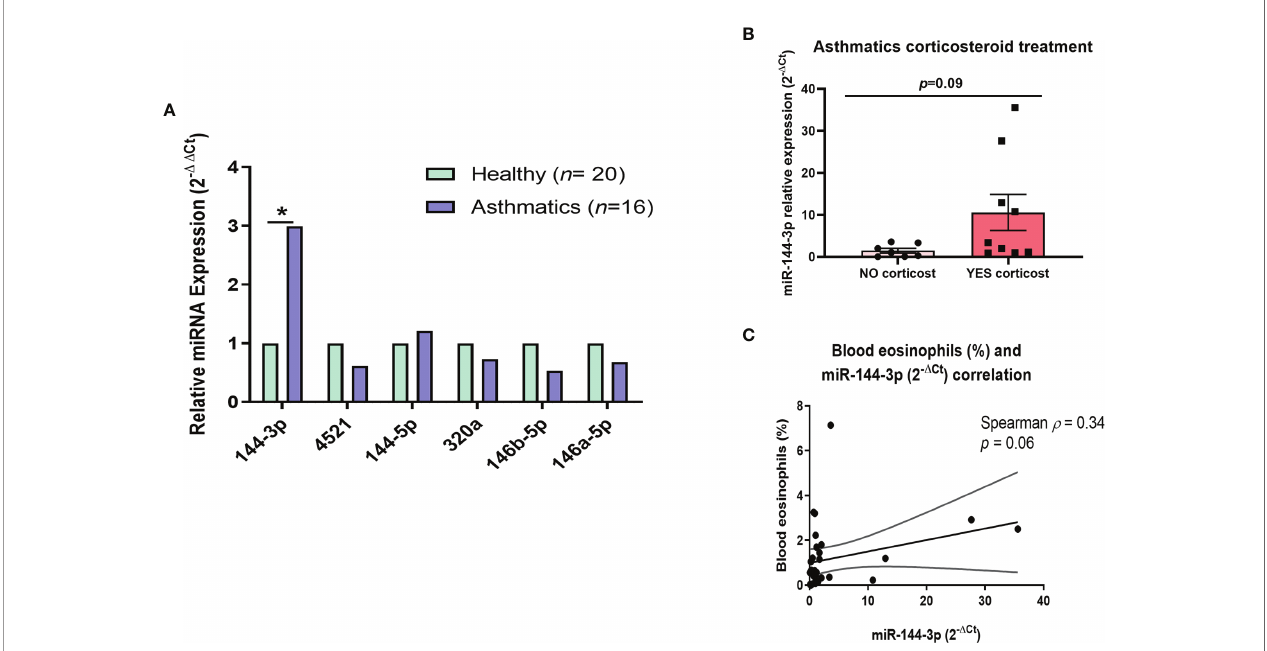
FIGURE 1 | MiR-144-3p expression is increased in lung tissue from asthmatics and correlates with clinical parameters. (A) Relative miRNA expression (2 - DD Ct ) in airway biopsies from asthmatics compared to controls. (B) Relative miR-144-3p (2 - D Ct ) expression in lungs from asthmatics treated with corticosteroids (YES corticost) and untreated (NO corticost). (C) The relative miRNA expression of miR-144-3p (2 - D Ct ) in lung correlates inversely with blood eosinophil percentage (%). * p < 0.05.